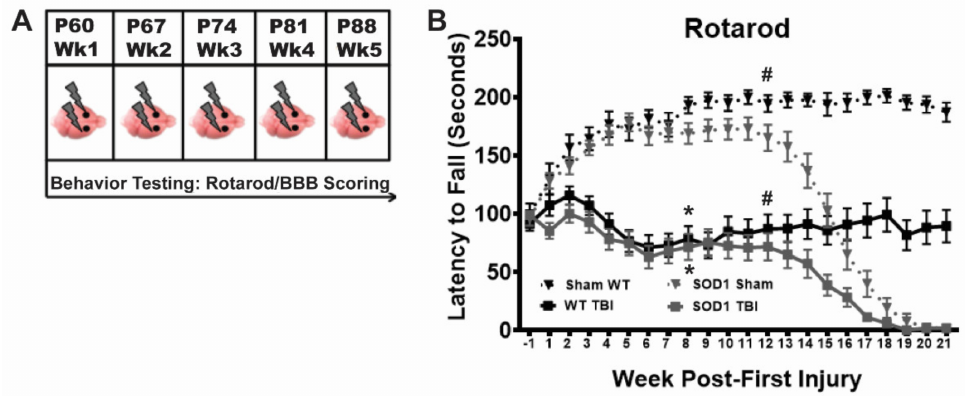
Figure 1. Repetitive bilateral mild traumatic brain injury (TBI) results in long term functional deficits in wildtype (WT) and SOD1 rats. ( A ) Rats in the TBI group received closed-skull bilateral controlled cortical impact (CCI) injuries to the motor cortex once a week for five weeks starting at postnatal day (P) 60 and behavior was monitored using Rotarod and Basso-Beattie-Bresnahan (BBB) scoring. ( B ) Both WT and SOD1 rats experiencing recurrent TBI (solid black and gray squares, respectively) exhibited significant early rotarod deficits, relative to both WT (dotted black triangle) and SOD1 (dotted gray triangles) sham. While TBI rats, regardless of genotype, appeared to recover following the second injury, after the third injury rotarod scores continued to decline and remained significantly lower than sham for the duration of the study. SOD1 rats in both sham and TBI exhibited disease-related progressive decline starting around week 13. (* SOD1 Sham vs SOD1 TBI, * WT sham vs WT TBI, # SOD1 Sham vs WT Sham, # SOD1 TBI vs WT TBI, Two-way ANOVA p < 0